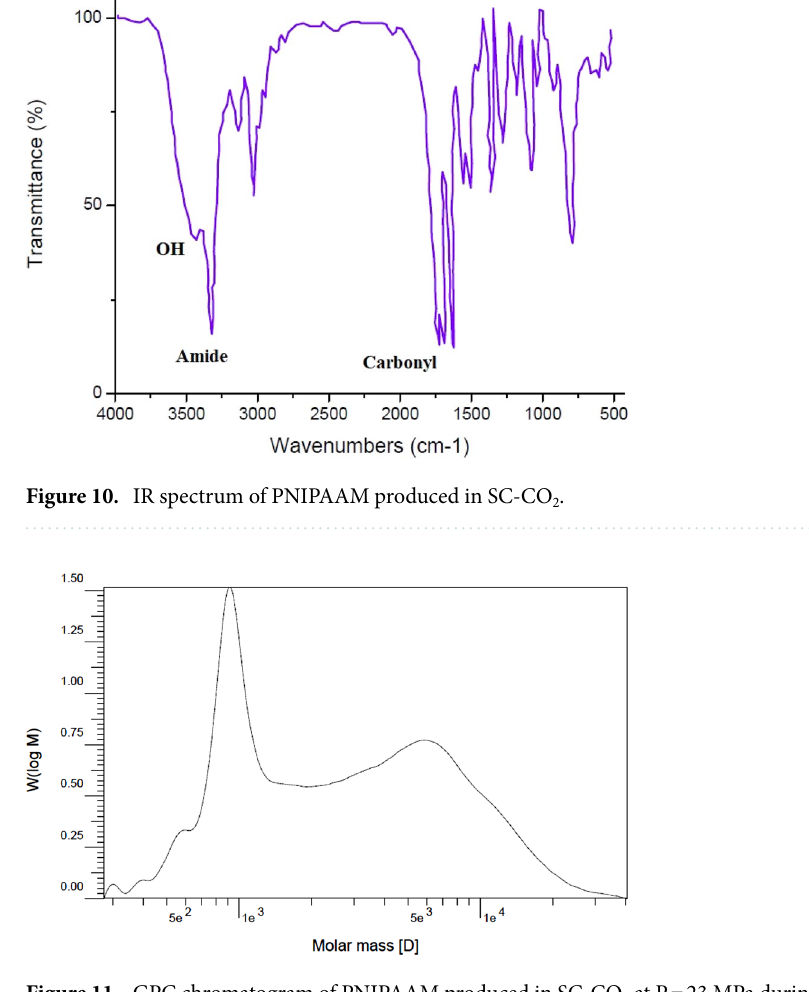
Figure 11. GPC chromatogram of PNIPAAM produced in SC-CO 2 at P = 23 MPa during 6 h, T = 70 °C, W i / W m = 1.5%, W t /W i = 83.3%, M w = 4368 (gr/mol), M n = 1680 (gr/mol) PDI = 2.6, and Mp = 914.5